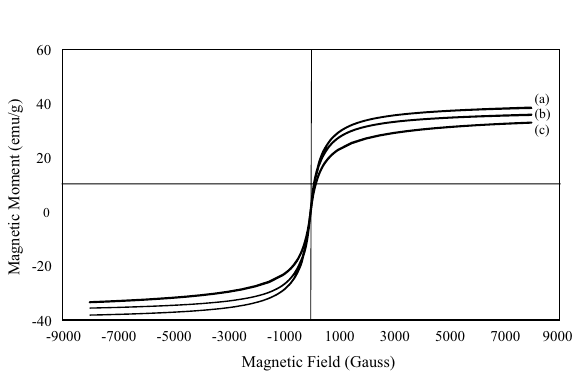
Figure 8. VSM diagram of ( a ) biochar/Fe 3 O 4 , ( b ) biochar/Fe 3 O 4 /PVIm and ( c ) biochar/Fe 3 O 4 /PVIm/Ag.